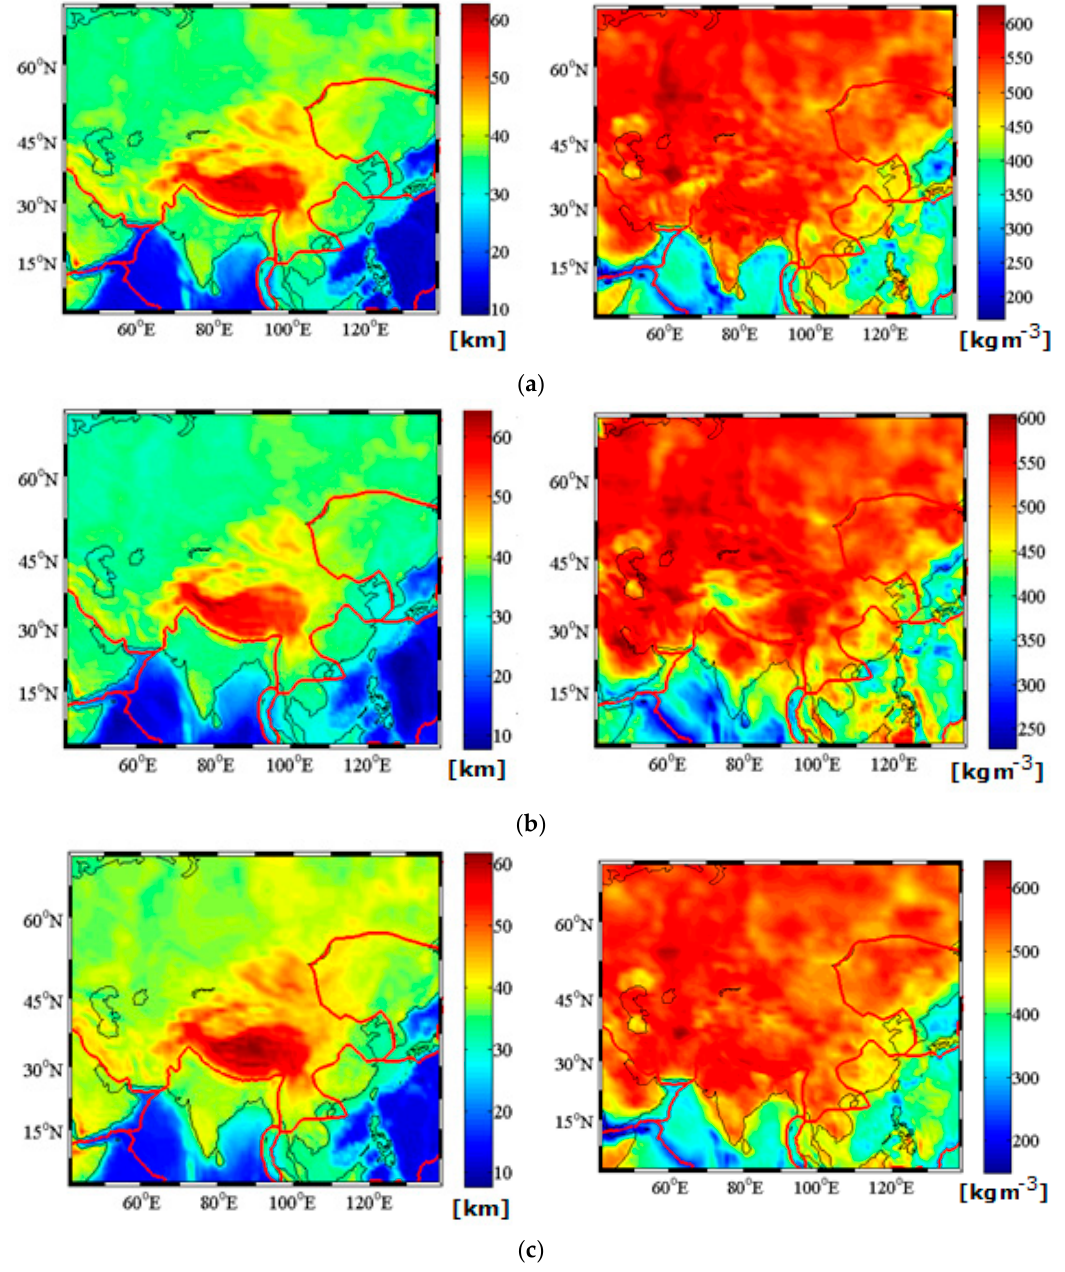
Figure 5. Combined solutions for the Moho depth ( left panels ) and density contrast ( right panels ): ( a ) R1_CRUST1.0; ( b ) R2_GSMM and ( c ) R3_M13.